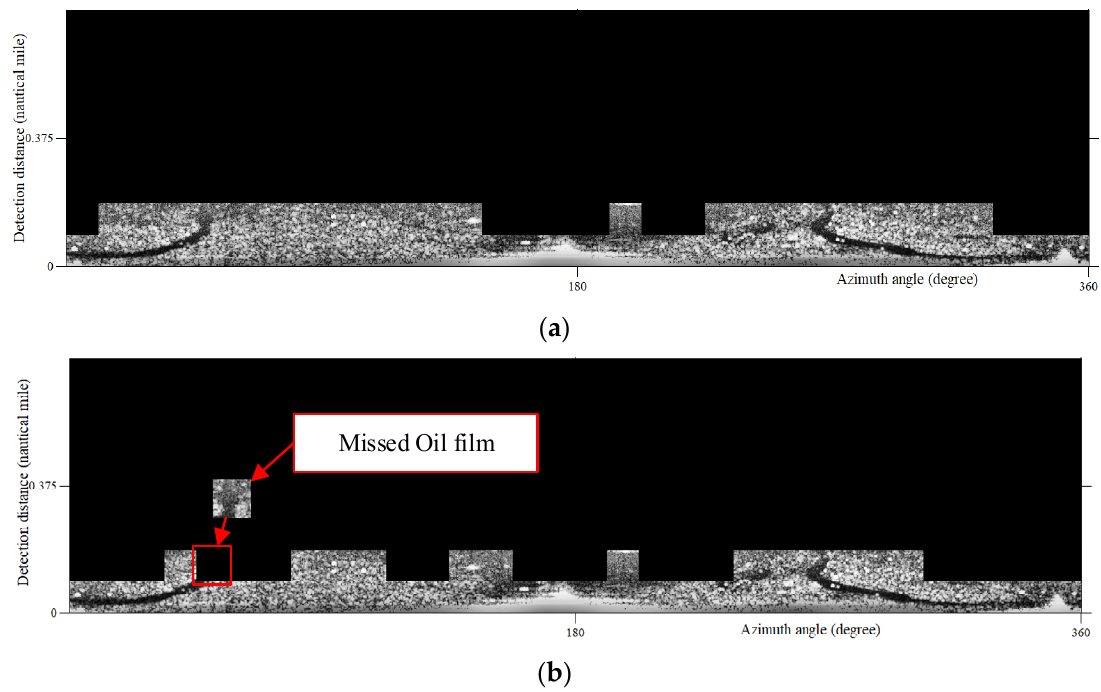
Figure 14. Effective area screening for ocean wave monitoring by using Correlation and Homogeneity of GLCM features. ( a ) Correlation; ( b ) Homogeneity. Red square with oil film had been removed in Homogeneity feature classification.